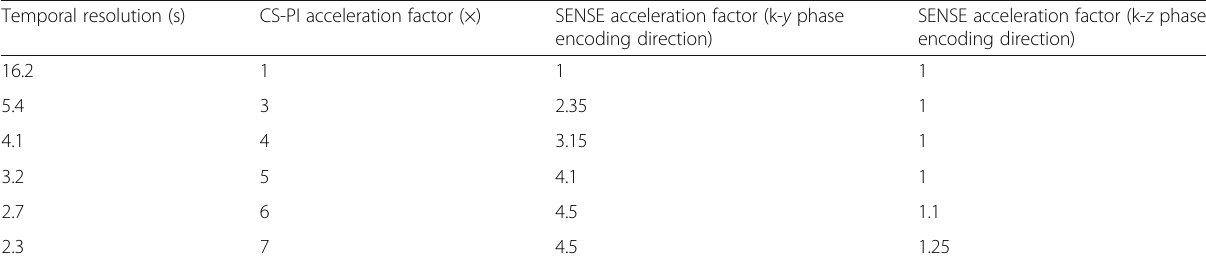
Table 4 Acceleration settings of the sampling trajectories for CS-PI and SENSE reconstructions Temporal resolution (s)